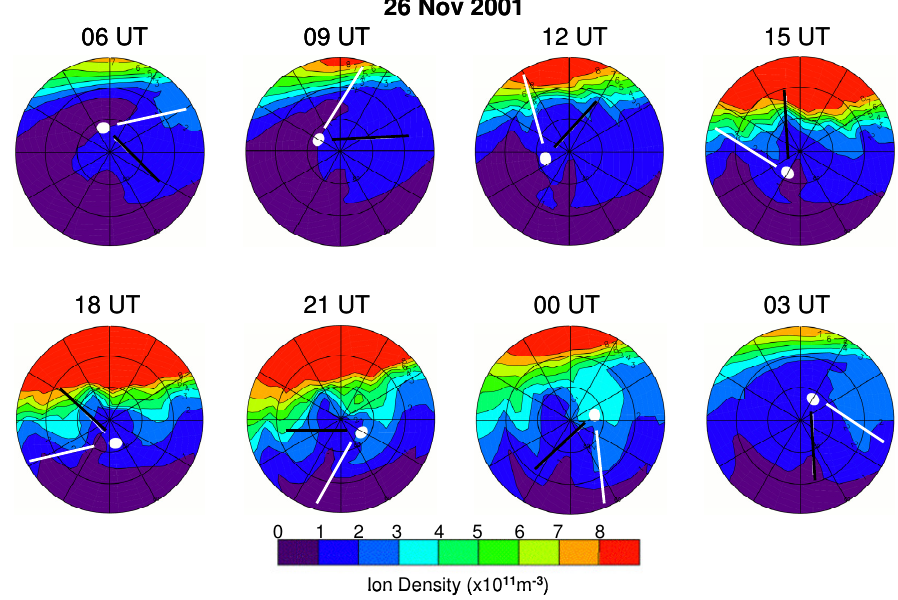
Fig. 11. Ion densities modelled by CTIP for 26 November 2001. The panels are at 3-h intervals of UT, with each panel showing the ion density distribution at an altitude of 270km, near the F-region ionisation peak, as a function of MLAT and MLT. The format of the panels is as for Fig. 4, with the white line showing the 18 ◦ E meridian near the longitude of the Scandinavian tomography chain and the black line indicating the 54 ◦ W meridian near the longitude of the Greenland chain.